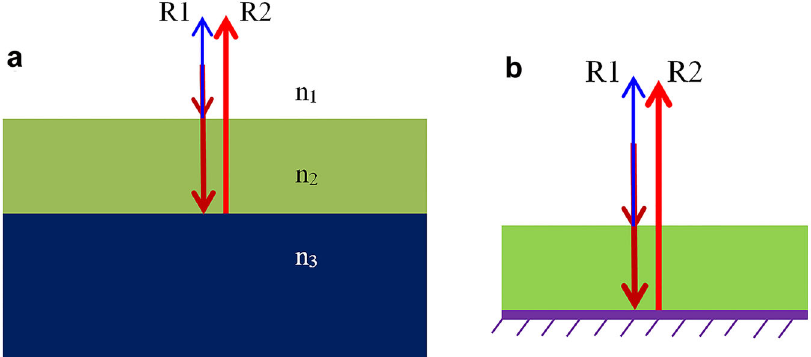
Fig. 5 Schematic structure of the SU8/Si material. a Schematic of the structure of SU8/Si material, where n 1 , n 2 , and n 3 represent the refractive indexes for air, SU8, and Si, respectively; R1 and R2 denote the re fl ectivity from the surface of SU8 and that from the Si surface, respectively. b Effective cavity formed in SU8/Si bilayer, where the bottom Si with large refractive index (n 3 ) is effective as a mirror. Light in the Fabry-Perot (F-P) cavity leaks out via two pathways as shown by the blue arrow line and the red